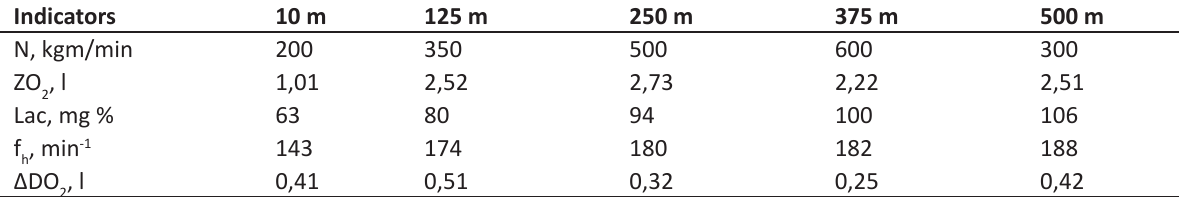
Table 3. Bio-energetic indicators of athletes, when fulfilling two minutes’ loads on row ergo-meter (regime A )